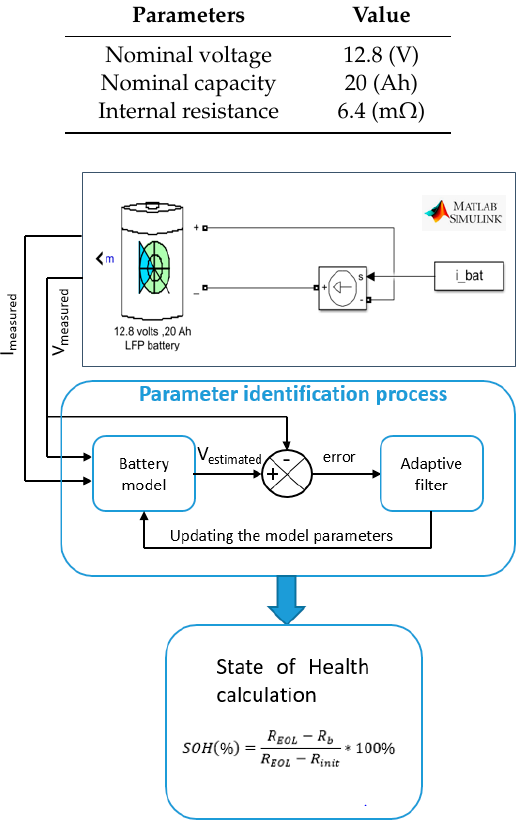
Figure 2. Online SOH estimation process.